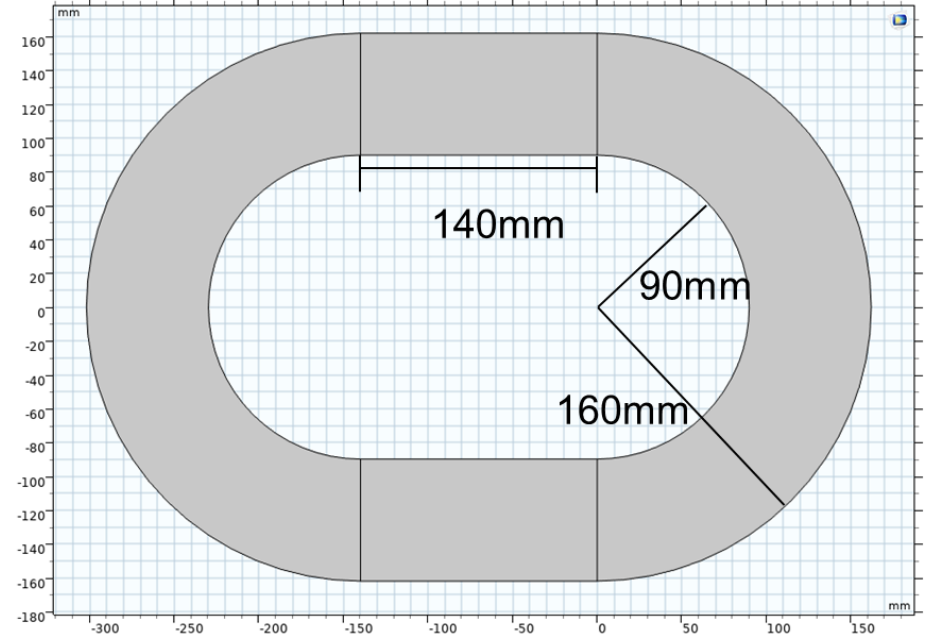
Figure 1. 2D plot of the HTS coils module.